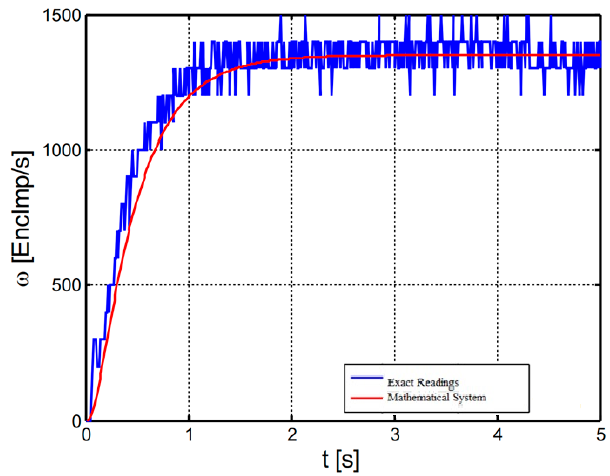
Figure 4. Step response speed of the